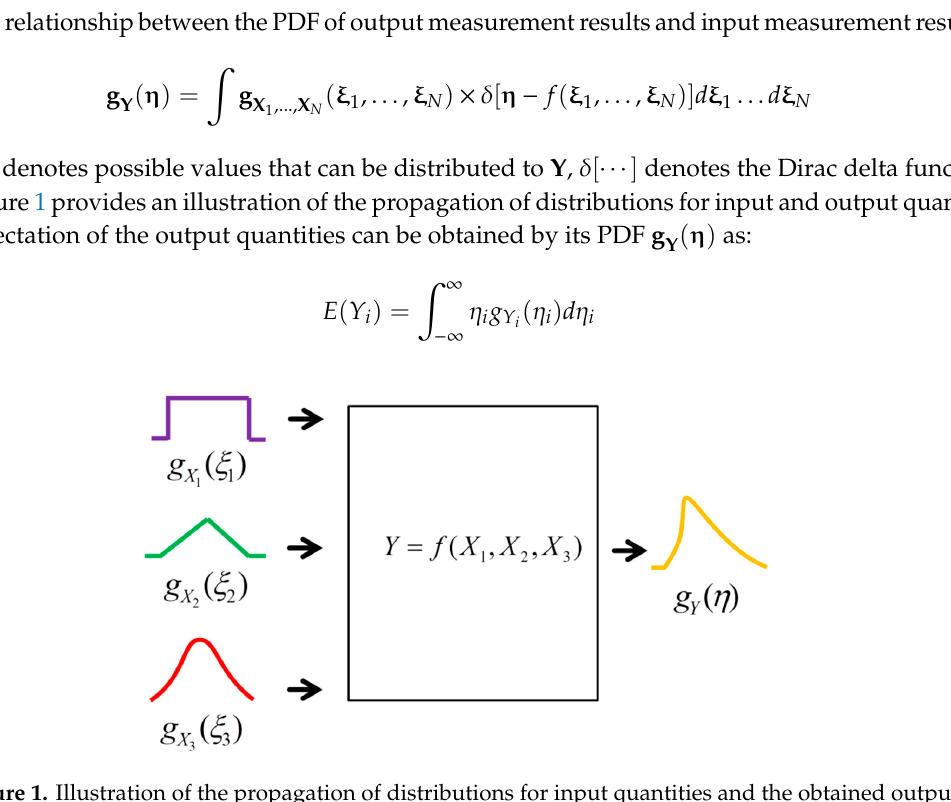
Figure 1. Illustration of the propagation of distributions for input quantities and the obtained output quantities [19].